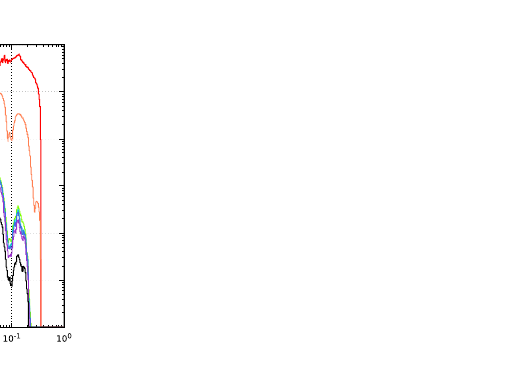
Figure 5. Spectrum at the BSA aperture (UGR) compared to others (FiR-1 and C-BENS) in log-lin scale ( upper panel ) and log-log scale ( lower panel ). The epithermal range from 0.5 eV to 10 keV is marked in gold and the extension from 10 to 20 keV in pale orange. The 2 keV energy is marked with a vertical dotted line.